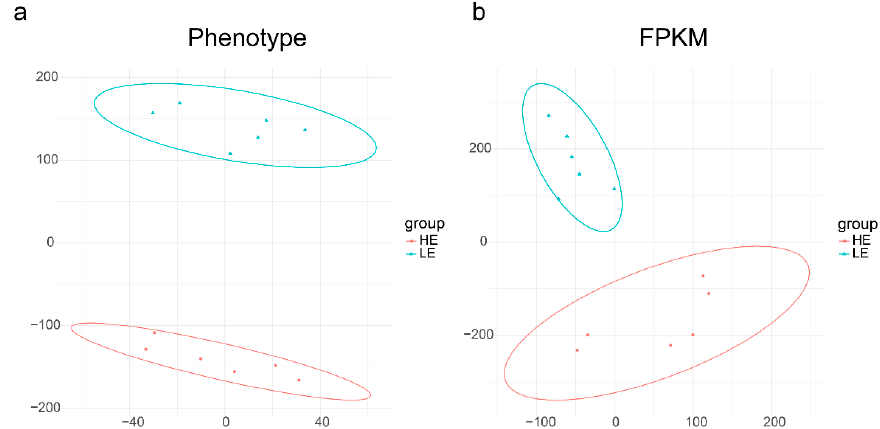
Figure 1. The t-distributed stochastic neighbor embedding (t-SNE) analysis of phenotype ( a ) and fragments per kilobase of transcript per million mapped reads (FPKM) ( b ) between HE- and LE-groups. ( a ). The t-SNE analysis performed on the feed efficiency (FE)-associated phenotype data. Dots represent samples and are colored according to FE phenotype: red (HE: high feed efficiency), blue (LE: low feed efficiency). The two group were well separated with six individuals in HE-group forming a cluster (red ellipse), and six individuals in LE-group forming a distinct cluster (blue ellipse). ( b ) The t-SNE analysis performed on FPKM expression values for all genes without a priori selection. Dots represent samples and are colored according to feed efficiency phenotype: red (HE: high feed e ffi ciency),